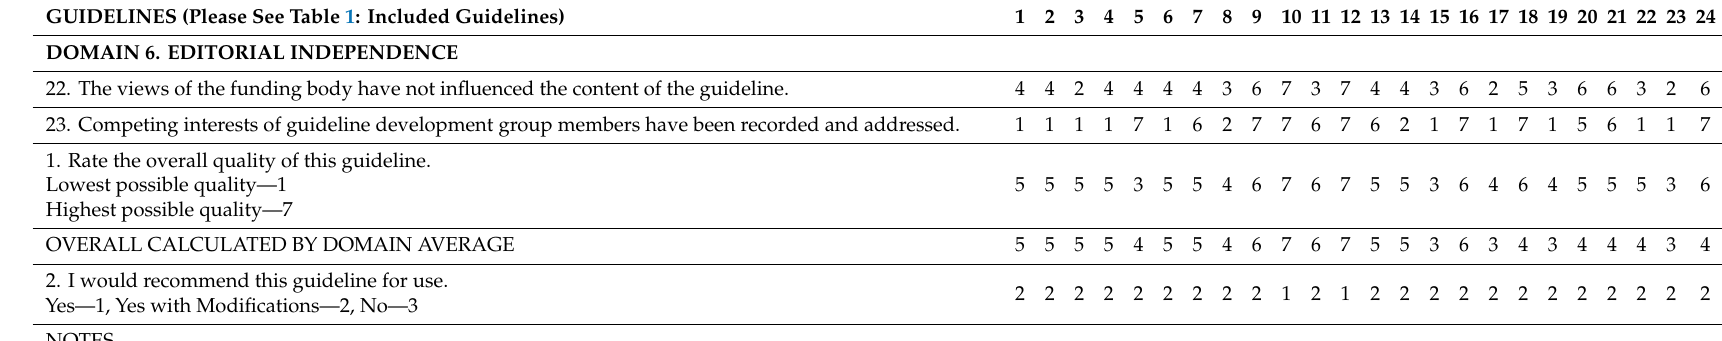
GUIDELINES (Please See Table 1: Included Guidelines)